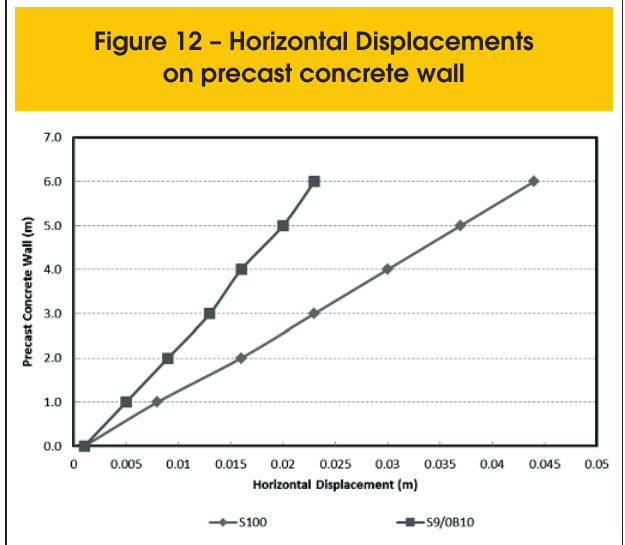
Figure 12 – Horizontal Displacements on precast concrete wall